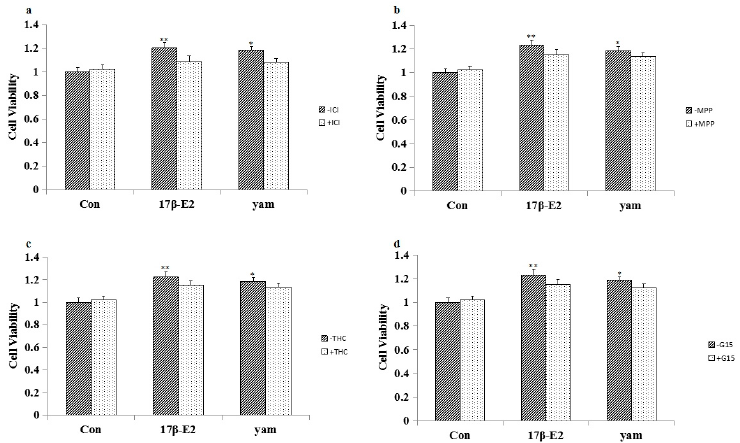
Table 3. The influence on MCF-7 cell proliferation (x ± SD, n = 4). Groups